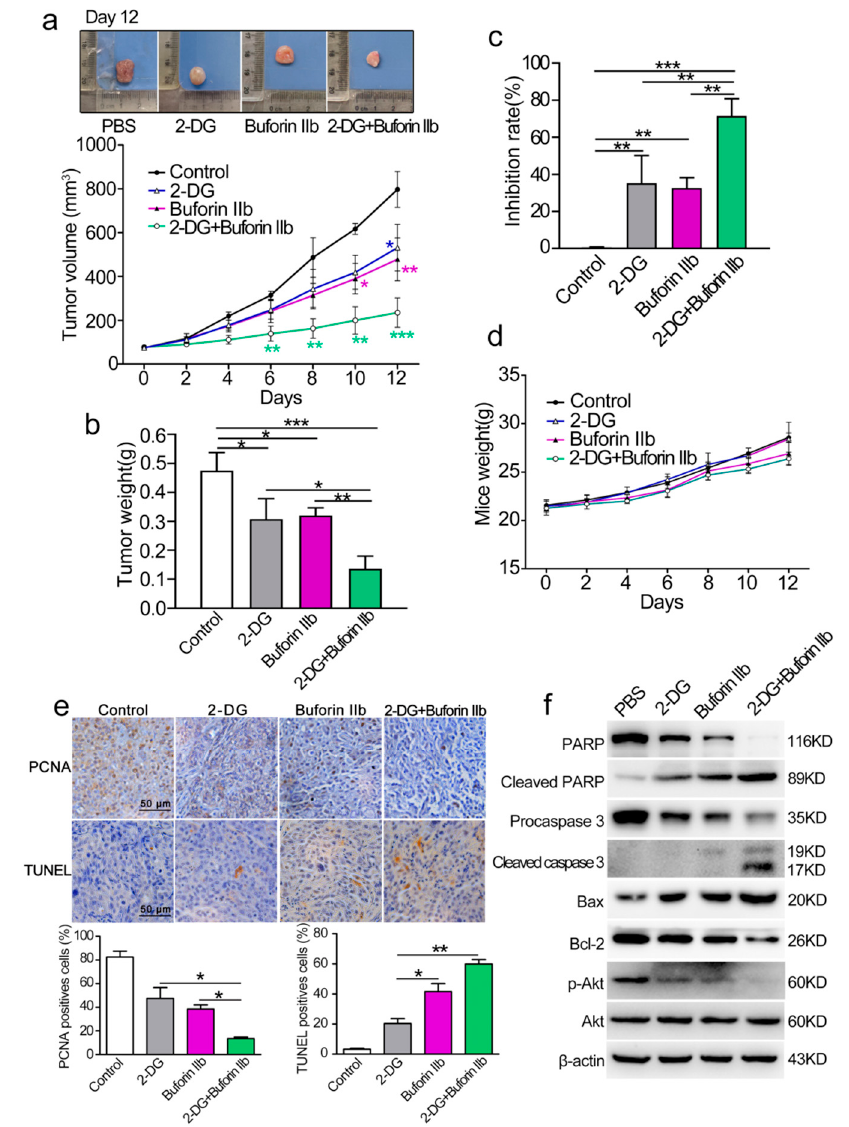
Figure 7. Effect of 2-DG combined with buforin IIb on DU145 xenograft tumors. ( a ) Tumor growth curves over time. The difference comparison was conducted between different treatment groups and PBS control group. ( b ) On day 12, tumors were carefully excised and tumor weight was measured. ( c ) Comparison of inhibition rate of tumor growth in different treatment groups. ( d ) Weight curves of mice over time. ( e ) Paraffin sections were examined by immunohistochemical staining using anti-PCNA antibody and TUNEL staining. Representative images from each group are shown. ( f ) Tumor tissues were crushed and lysed with RIPA lysis buffer, and the supernatants were collected for western blot analysis using the indicated antibodies. Similar results were obtained in at least three independent experiments. * p < 0.05, ** p < 0.01, *** p < 0.001.